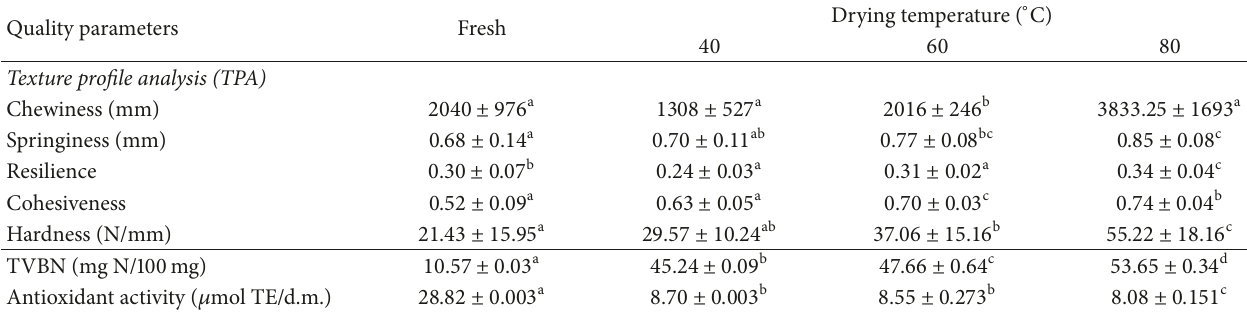
Table 2: Quality parameters such as TPA, TVBN, and antioxidant activity of fresh and dehydrated samples. Quality parameters